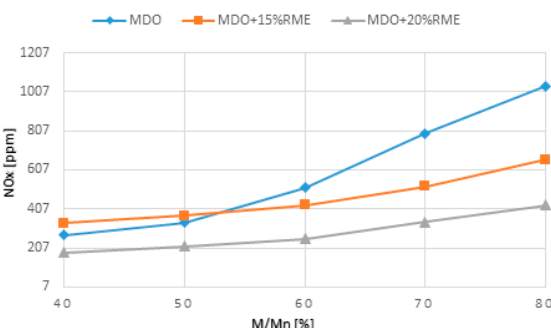
Figure 5. NO x content in exhaust gas as a function of the engine load for different kinds of fuel at a constant rotational speed n = 220 rpm.